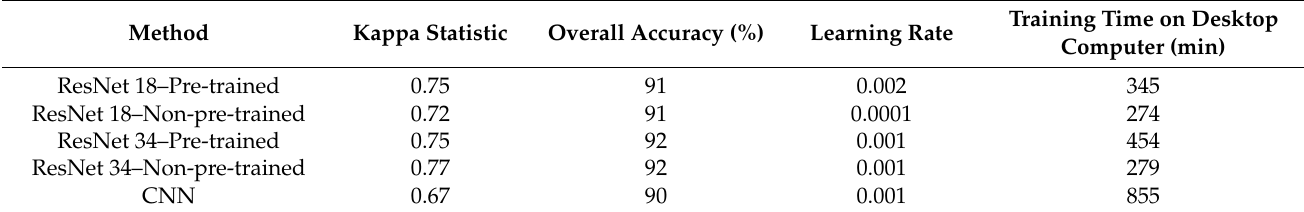
Table 3. Computational times to convergence for neural networks tested by